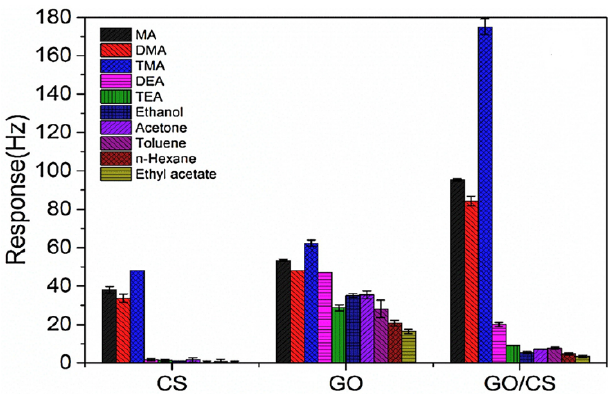
Figure 8. Comparison of the responses of pure CS-, GO-, and GO/CS-coated QCM sensors to 50 ppm of various organic vapors. Reproduced with permission from Zhang et al., Sens. Actuators B Chem.; published by Elsevier, 2017 [156].